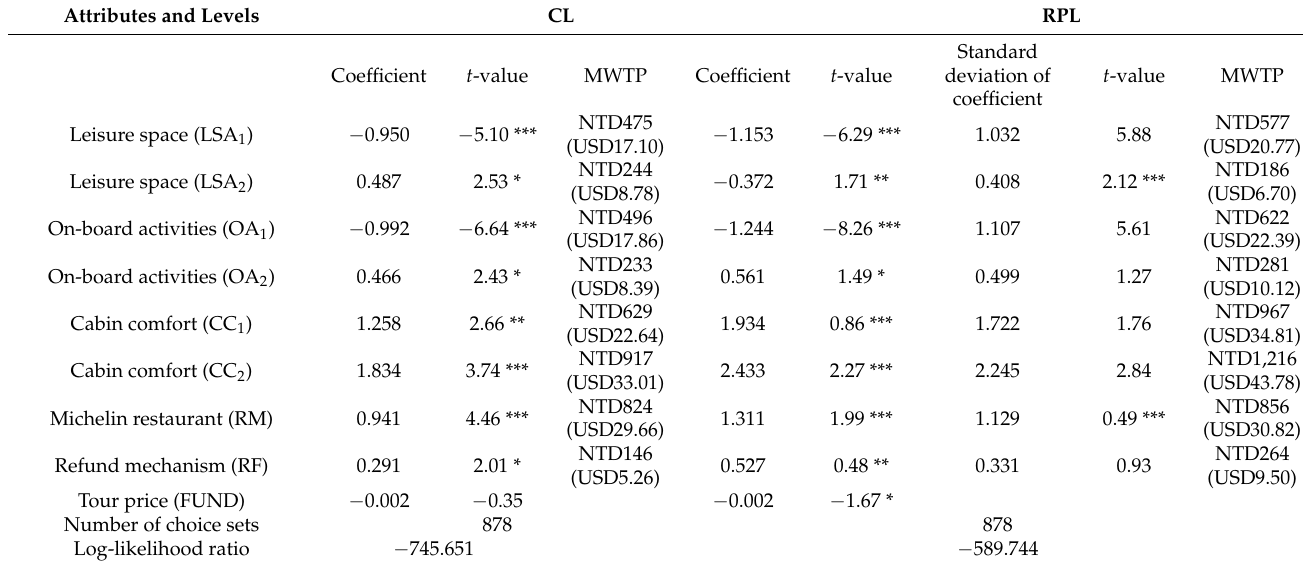
Table 3. Empirical estimation results of CL and